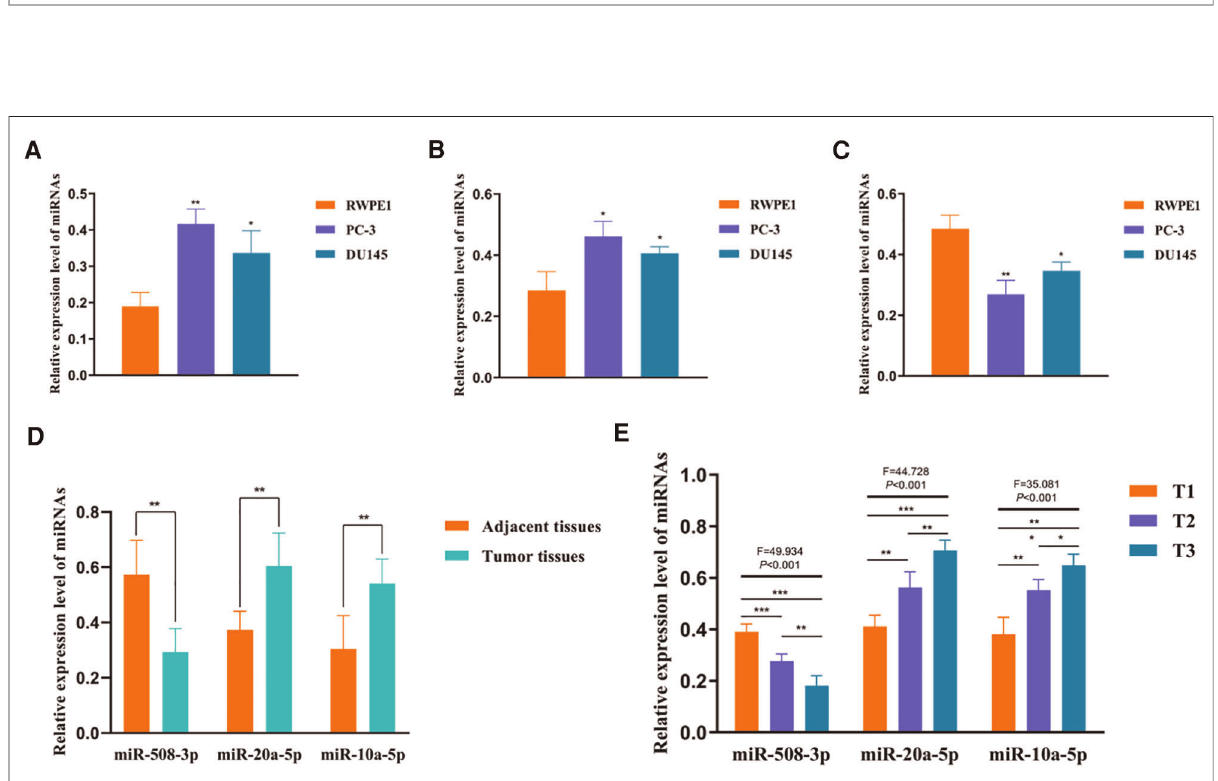
FIGURE 8 Functional enrichment analysis of target genes. The top pathways of target genes were demonstrated in biological process, cellular component, molecular function ( A ), and KEGG pathway ( B ).